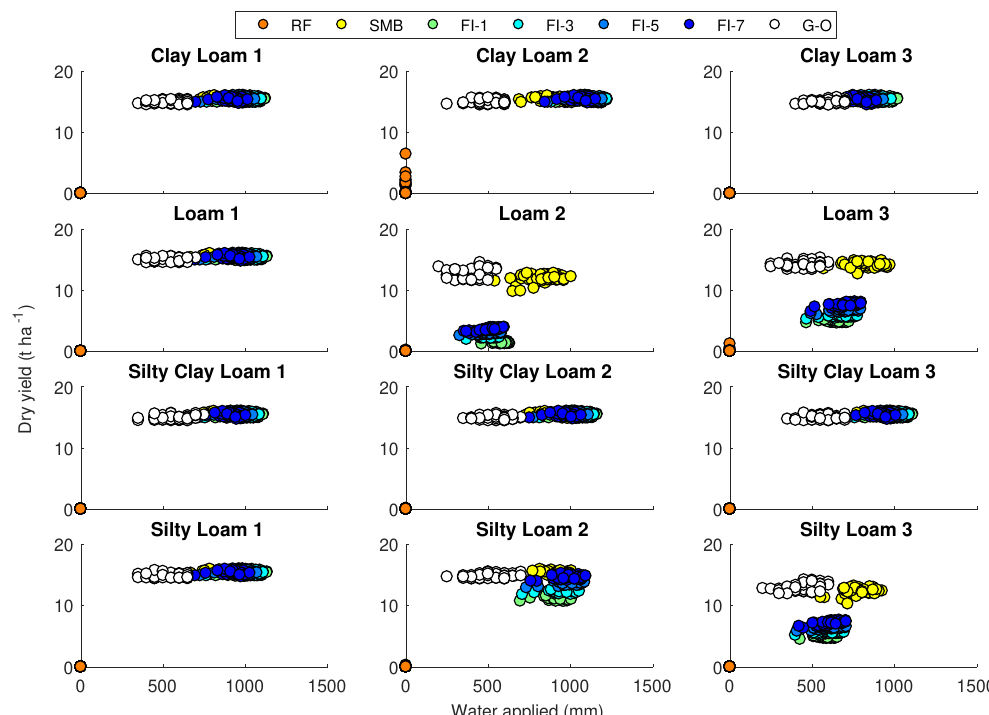
Figure 4. Dry yield as a function of water use for maize for soils with low (1), medium (2), and high (3) bulk densities under different irrigation strategies: RF: Rainfed; SMB: Soil moisture-based; FI: Fixed interval every 1, 3, 5, and 7 days; and G-O: GET-OPTIS considering simulated values from 1965 to 2016.